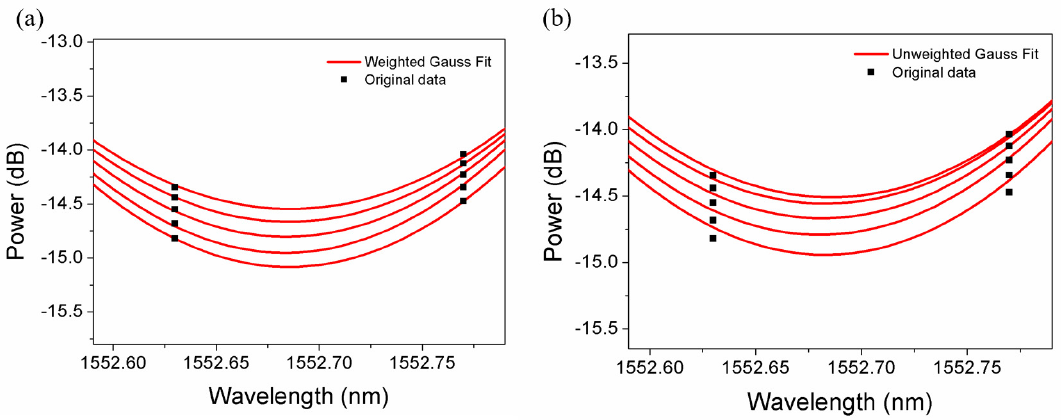
Figure 13. Transmitted spectra of the cladding mode No. 10 with weighted ( a ) and unweighted ( b ) Gauss fitting in terms of SRI change 8.8 × 10 − 5 for the wavelength resolution 0.14 nm.